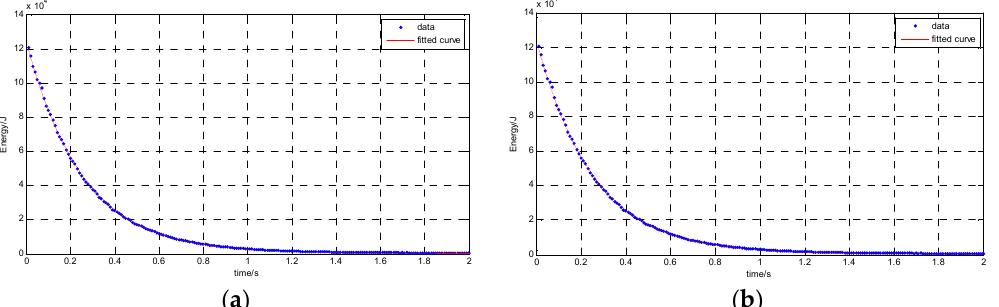
Figure 25. The energy time history with thickness t = 0.01 m, x = 0.0 m and z = 0, z = L/2 respectively. ( a ) z = 0.0 m. ( b ) z = L/2 m.